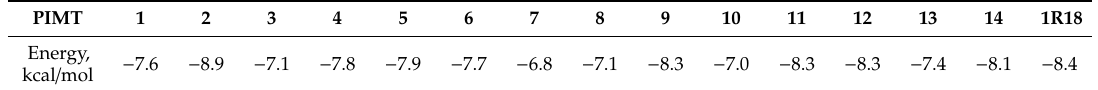
Table 2. The a ffi nity energy of SAM and paralogous PIMT